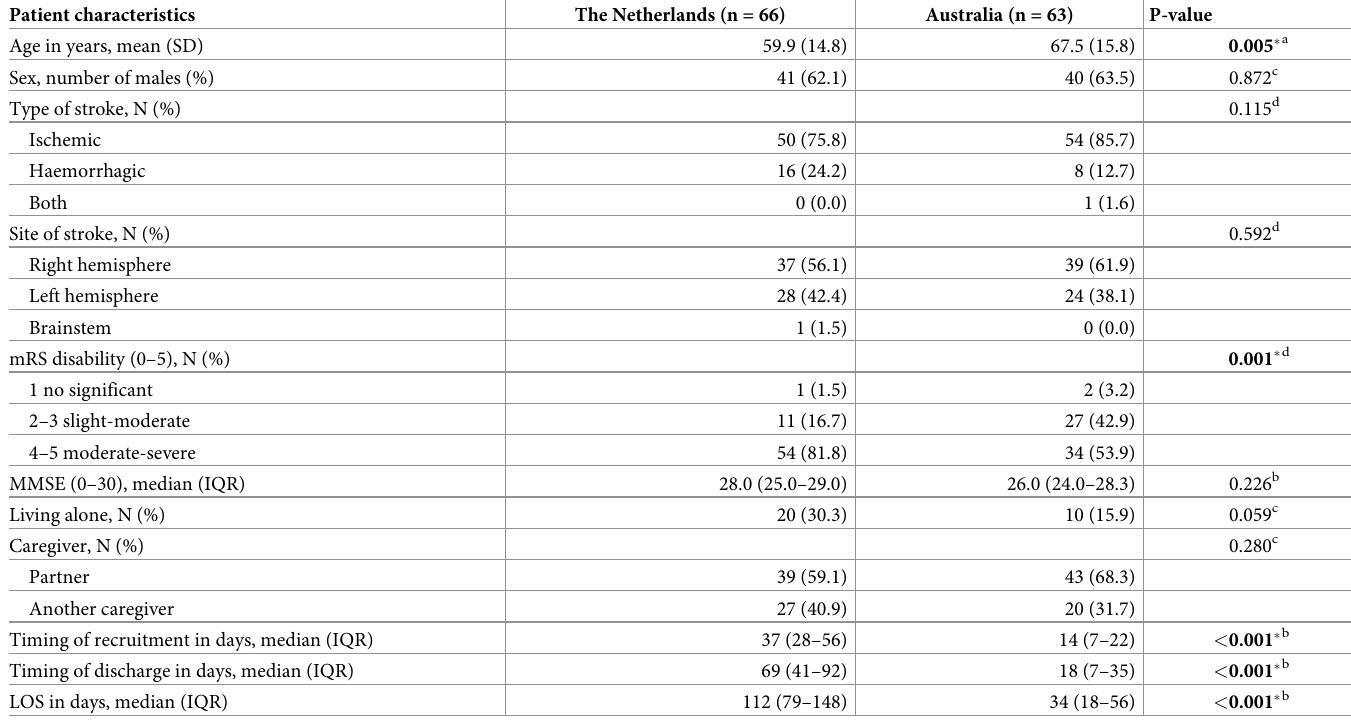
Table 1. Differences in patient characteristics and process